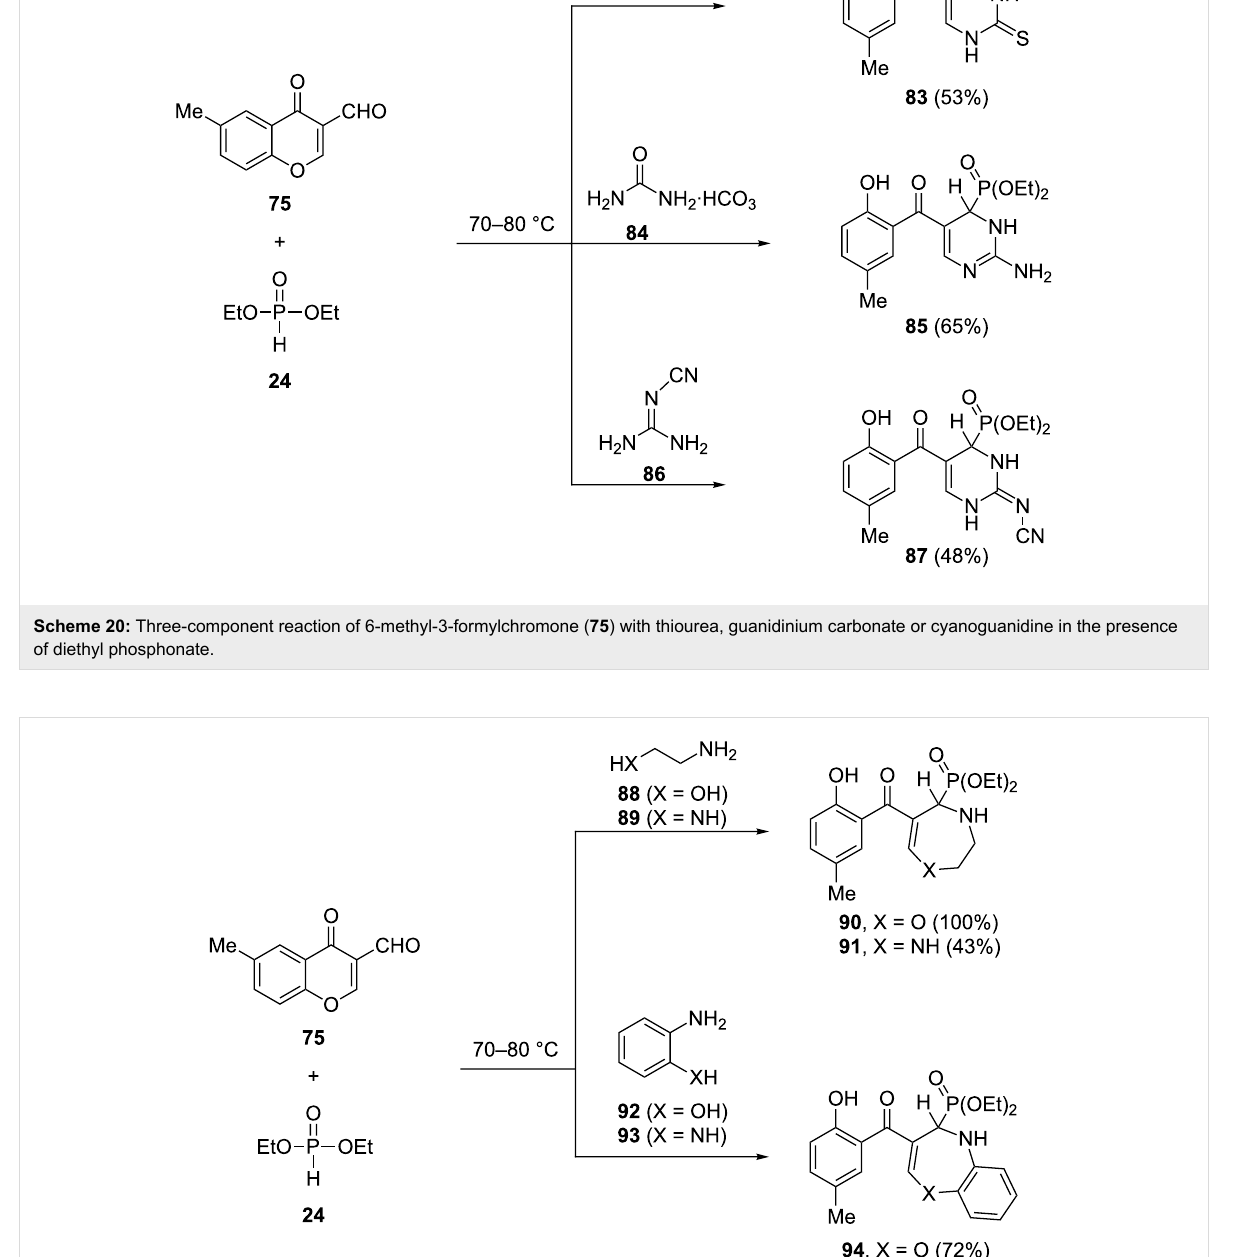
phosphonate catalyzed by C 12 H 25 SO 3 Na–CuSO 4 (10 mol %)